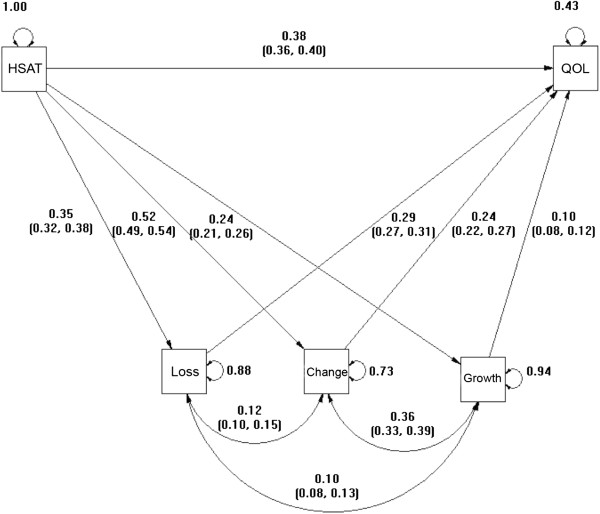
Global QOL path model with standardized coefficient and variance estimates.